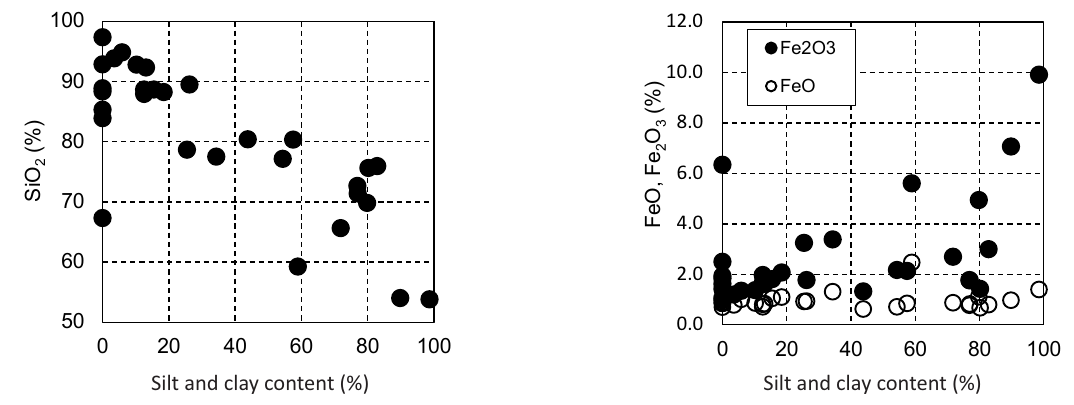
Silt and clay content (%) Fig. 6. Bivariate plots showing the SiO 2 , FeO and Fe 2 O 3 contents versus the silt and clay content of terrigenous rocks.